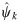
Visualizing and quantifying local distortions of grid patterns.a, b) Generated spike locations with noise on grid field locations applied only on the east side of the arena (see text for details, 2 example cells). The color of each spike location shows the ψ^k score. Shown above: Ψ score. c) East-west (left) and south-north (right) partitioning of the arena. Black lines show partition boundaries. Colors of partitions indicate the Ψ score within the partition for the examples in a (top) and b (bottom). d) Ψ score in partitions along west-east axis (dark blue) and south-north axis (light blue). Crosses show results for 10 randomly generated spike maps with noise on field locations applied only on the east side. Filled circles indicate the mean over 10 realizations. e) Spike locations of two example cells recorded in a rat that explored the northern and southern half of a box. The two halves are separated by a wall (dashed gray line). The spikes in each half were recorded in separate sessions. Color-coding as in a. f) Spike locations of the two cells shown in e while the rat explored the entire arena after the separating wall was removed. g) Grid score in south-north partitions before wall removal (left) and after wall removal (right) for the cells in e, f. Color-coding as in c. h)Ψ scores in the south-north partitions shown in g for 11 recorded cells. Crosses denote individual cells, filled circles the mean across cells. Ψ scores before wall removal in dark blue, Ψ scores after wall removal in light blue. i)Ψ scores in west-east partitions for the cells in e, f. Arrangement as in g. j)Ψ scores in the west-east partitions shown in i. Same recordings and arrangement as in h. Data in panels e-j kindly provided by [19].